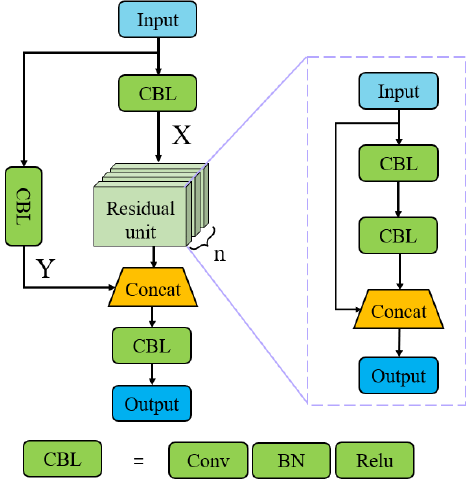
Figure 2. Residual module structure diagram. Conv: Convolution with kernel size 3 × 3, Strides = 2; BN: Batch Normalization; Relu: Rectified Linear Unit.